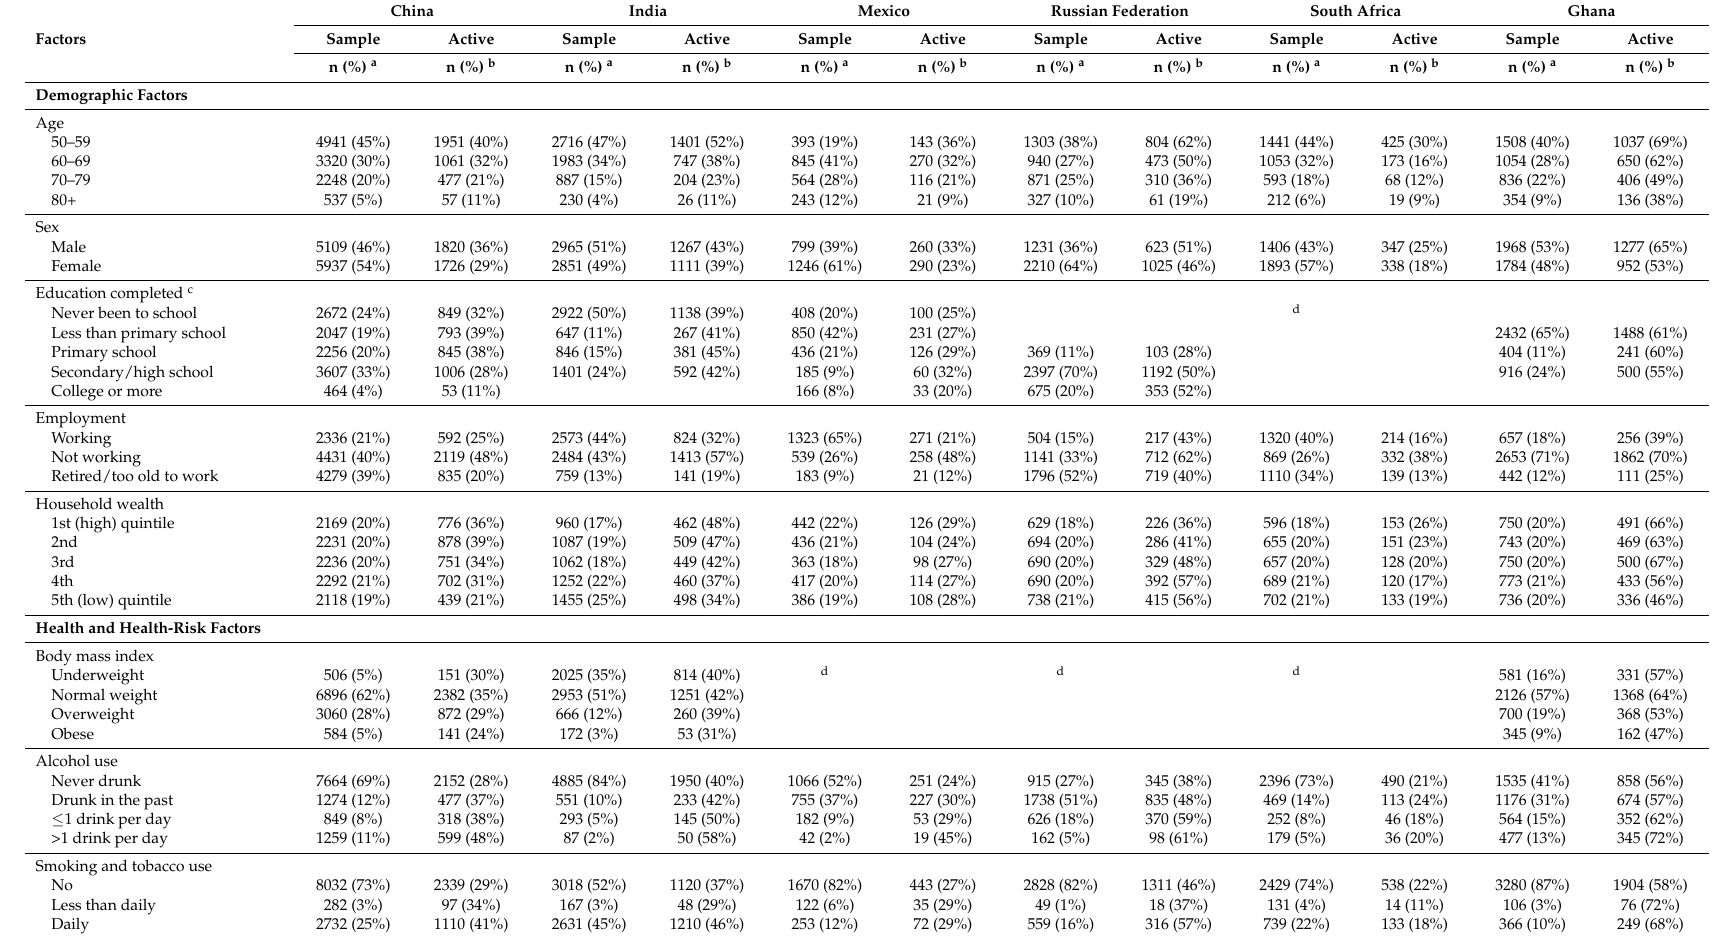
Table 1. Descriptive statistics for the samples of adults and for those meeting physical activity guidelines